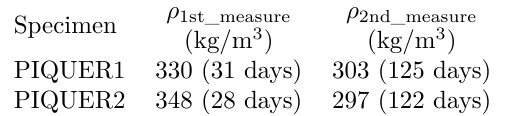
Table 1. DHCF_PP mix design.